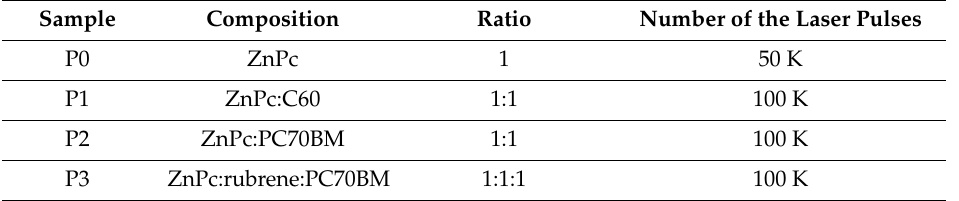
Table 1. Organic layers deposited by MAPLE, their composition, the ratio between their components, and the number of laser pulses used in the deposition of each organic layer.